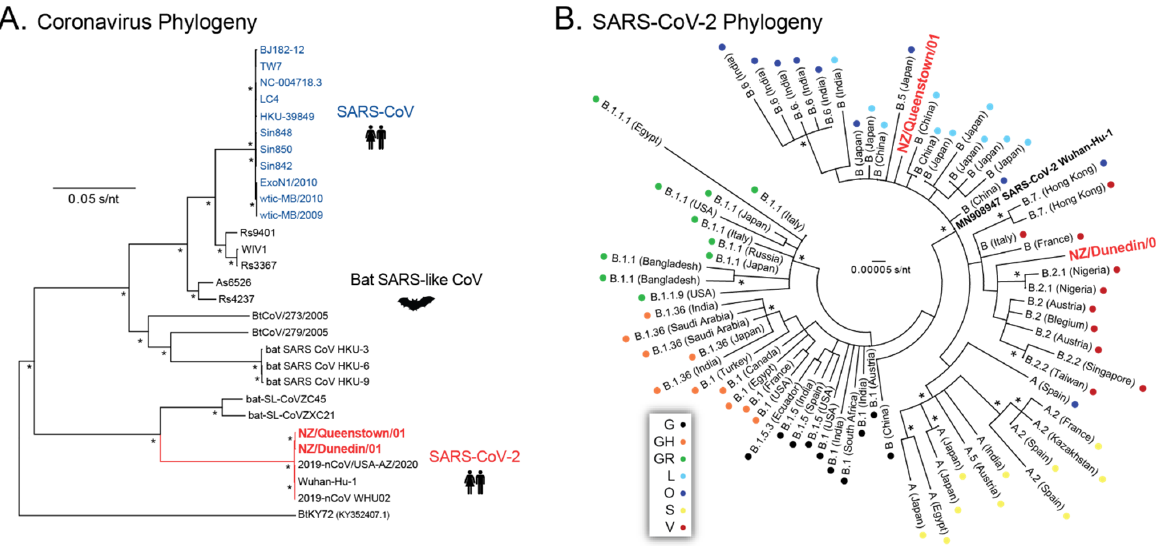
Figure 5. Phylogenetic analysis of the first two SARS-CoV-2 infections in the South Island, New Zealand. Maximum Likelihood phylogenetic trees were constructed using whole-genome SARS-CoV-2 consensus sequences corresponding to the first two COVID-19 cases identified in the South Island (NZ/Queenstown/01 and NZ/Dunedin/01) and 28 SARS-like betacoronaviruses ( A ) or 70 contemporary SARS-CoV-2 sequences from different lineages ( B ) obtained from GISAID database (https://www.gisaid.org/, accessed on 15 April 2020) in June 2020. Each color-coded dot represents SARS-CoV-2 GISAID clades. Bootstrap resampling (1000 data sets) of the multiple alignments tested the statistical robustness of the trees, with percentage values above 75% indicated by an asterisk. s/nt, substitutions per nucleotide.